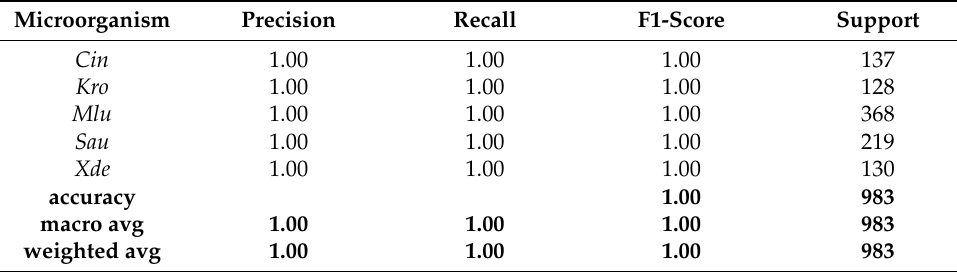
Table 5. Precision, recall, F1 score and support with model 2 for carotenoid-containing microorganisms. Microorganism